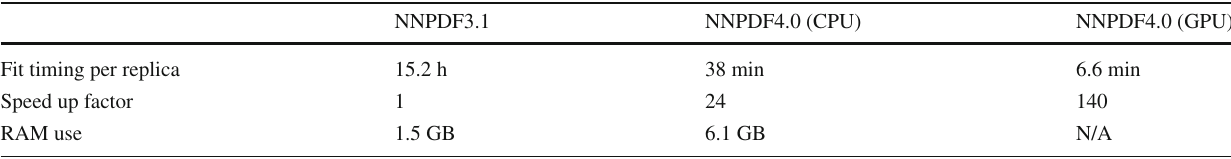
Table 10 The average fitting time per replica, speed up factor (as com- pared to the NNPDF3.1 performance), and the RAM requirements in global PDF fits based on the NNPDF3.1 and NNPDF4.0 frameworks